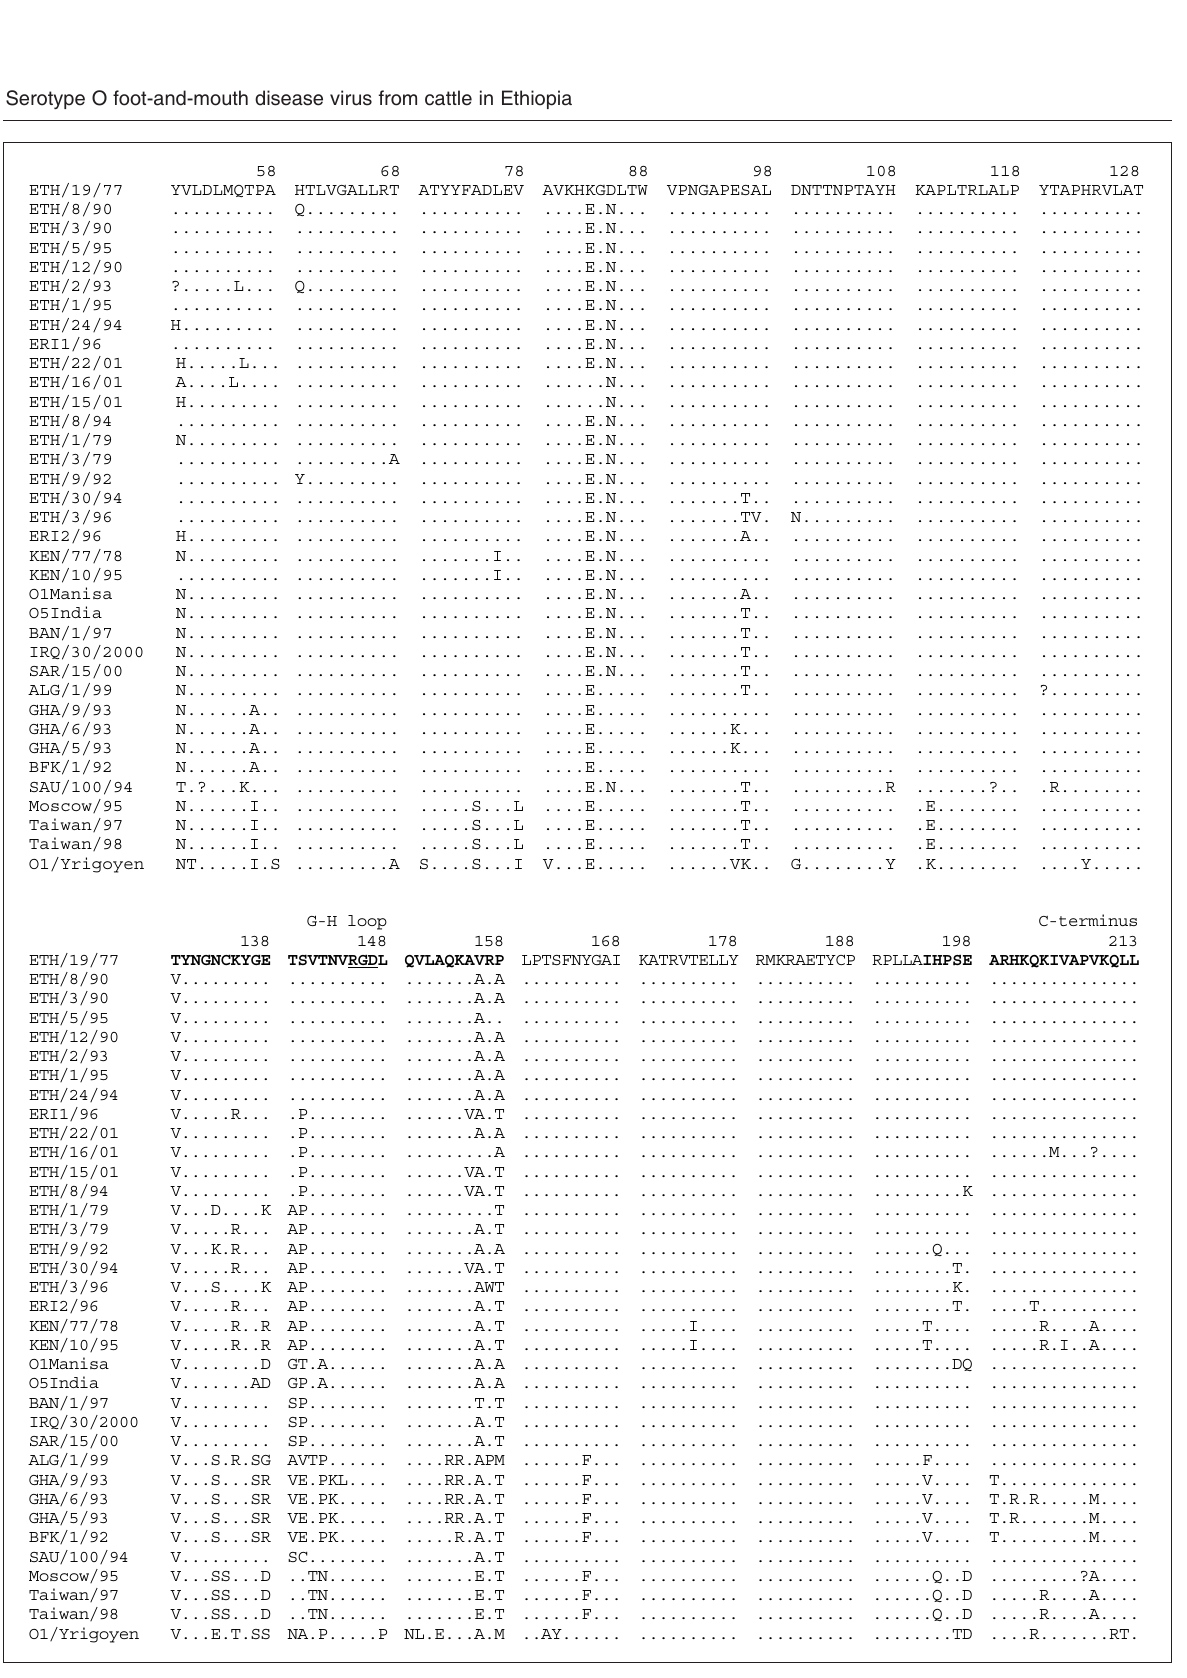
FIG. 2 Sequence alignment of 165 amino acids from the C-terminal end of the 1D gene of 36 type O FMD viruses. The main immunodominant regions are indicated in bold. Cell attachment site (RGD) in the GH-loop of the viruses, at position 145– 147, is underlined. Dots (.) indicate amino acids identical to the vaccine strain ETH/19/77. '?' indicates amino acids that could not be determined due to nucleotide sequence